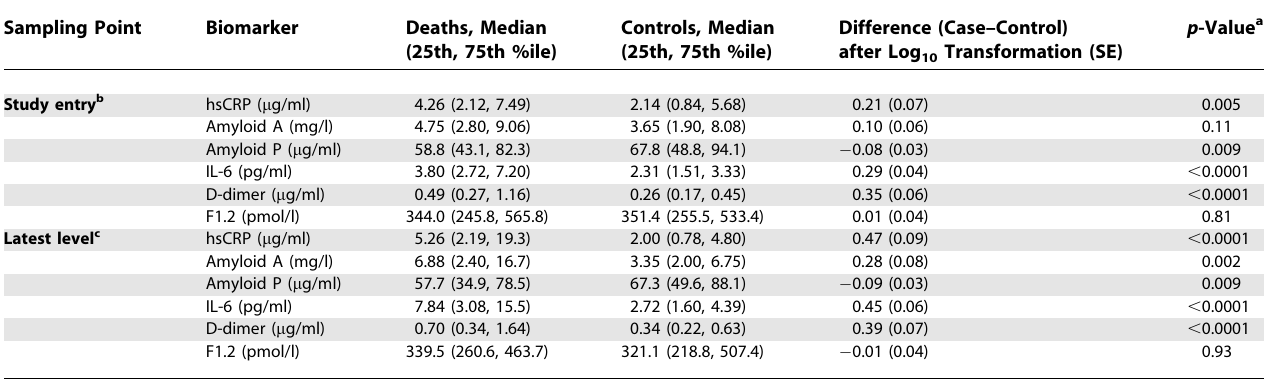
Table 2. Study Entry and Latest Levels of Six Biomarkers for Deaths and Matched Controls Sampling Point